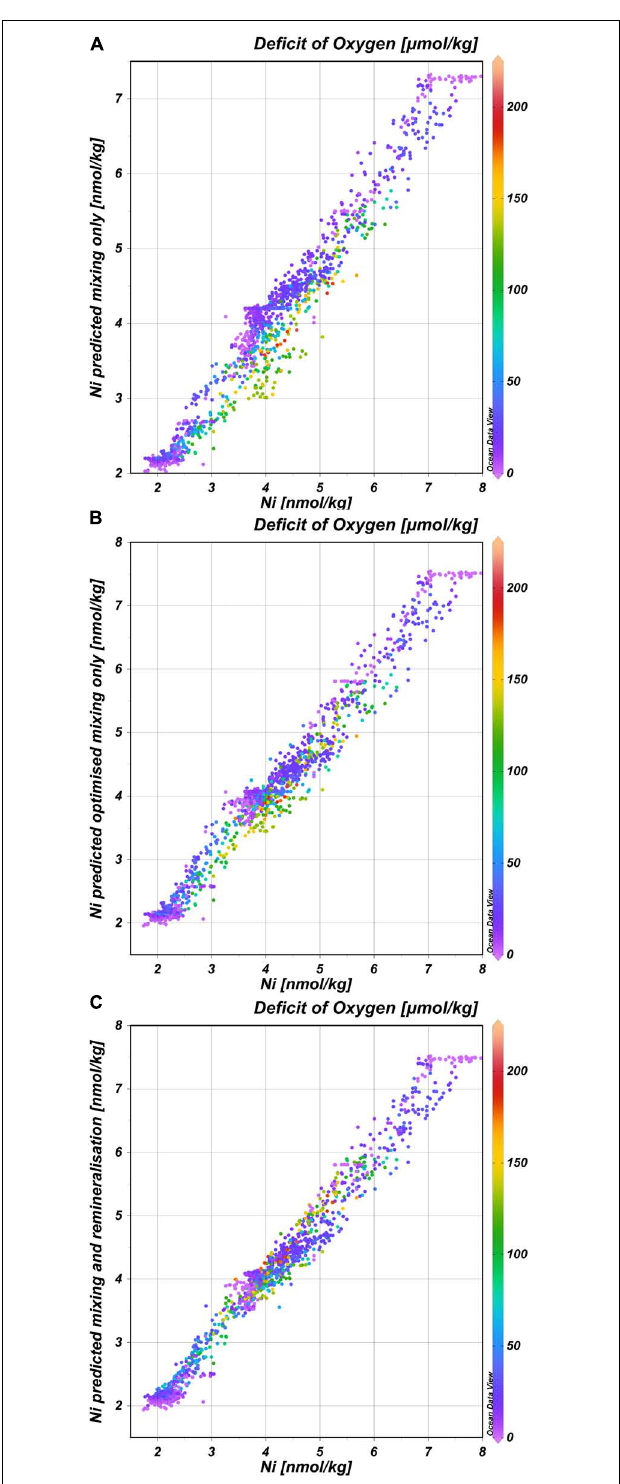
FIGURE 5 | Concentrations of Ni as predicted by the eOMP model versus the observations. (A) Concentrations of Ni predicted using the estimated endmembers and mixing only (Ni pred ), versus observed Ni concentrations (Ni obs ); Ni pred = 0.93 Ni obs + 0.22; R 2 = 0.95; rmse = 0.28 nmol kg − 1 .